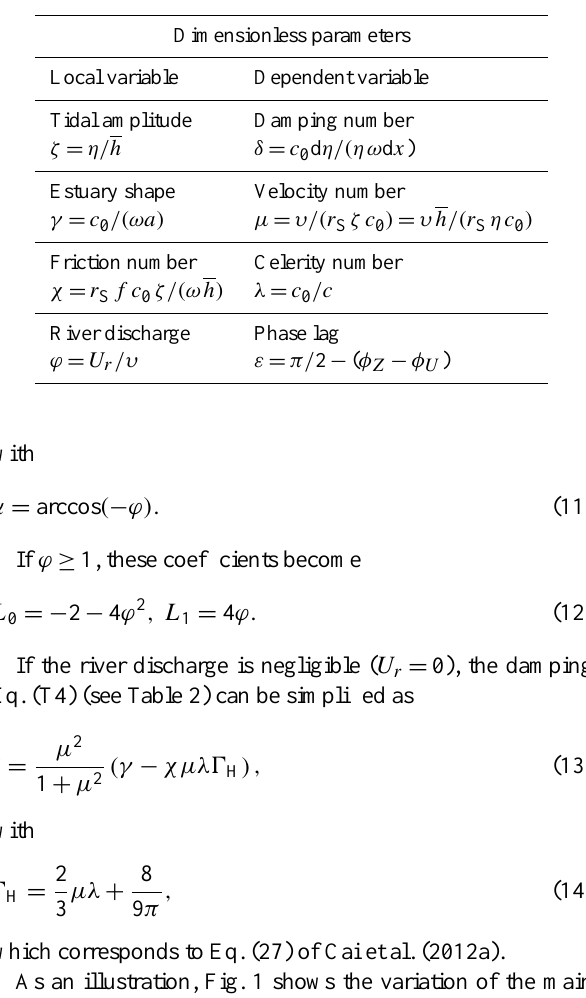
Table 1. Definition of dimensionless